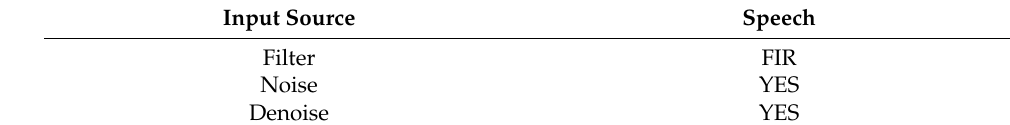
Table 4. Simulation parameters of scenario 3.